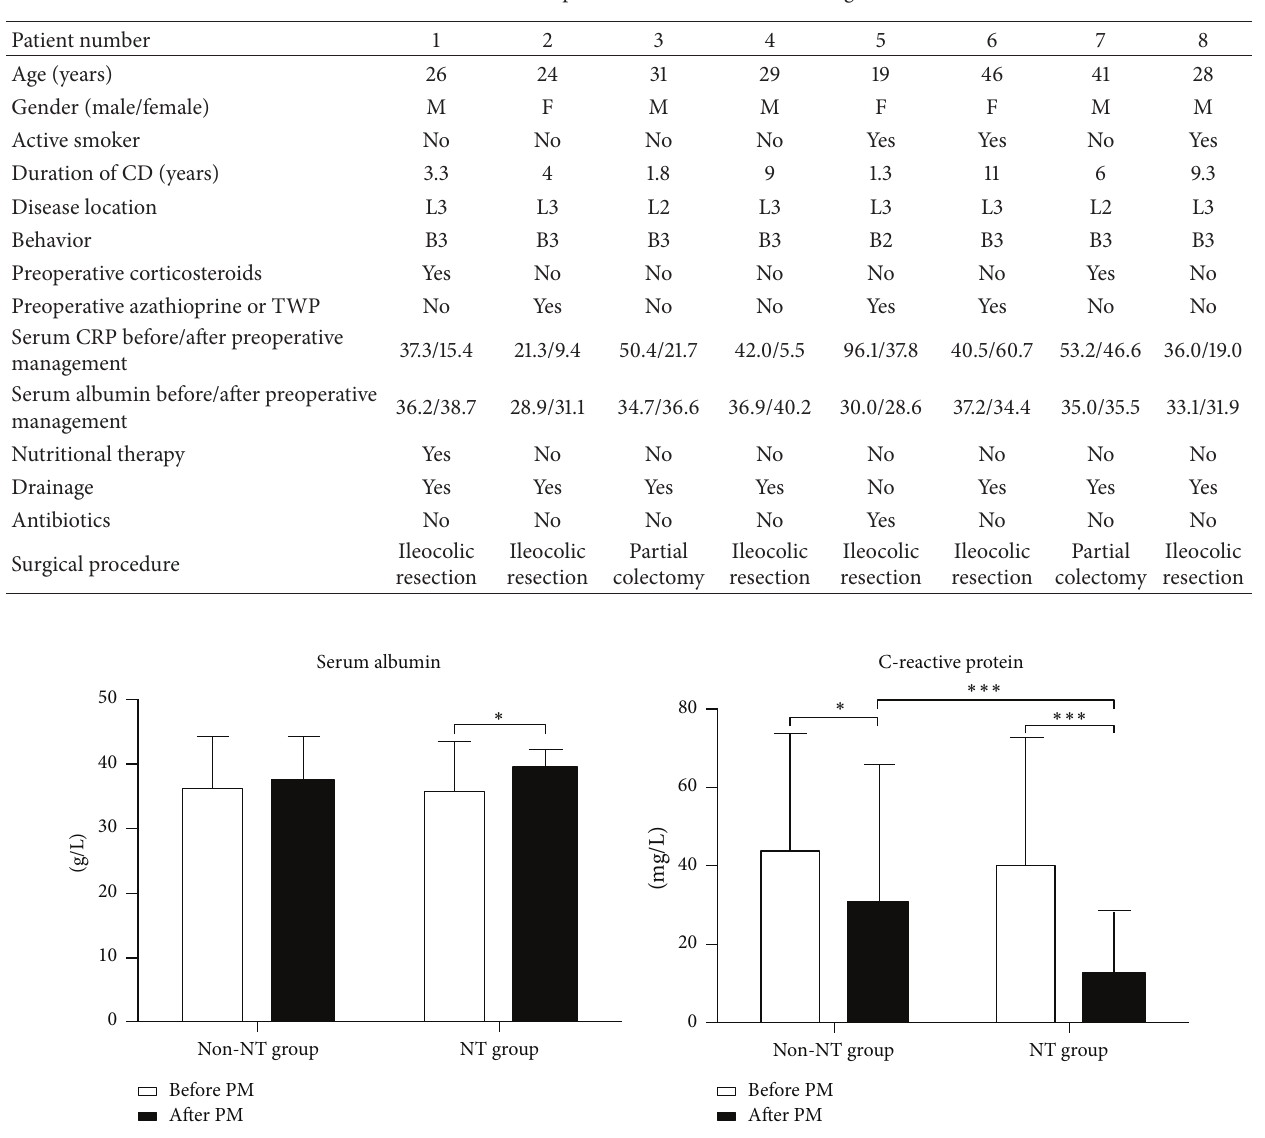
Table 3: Details of patients with anastomotic leakage.